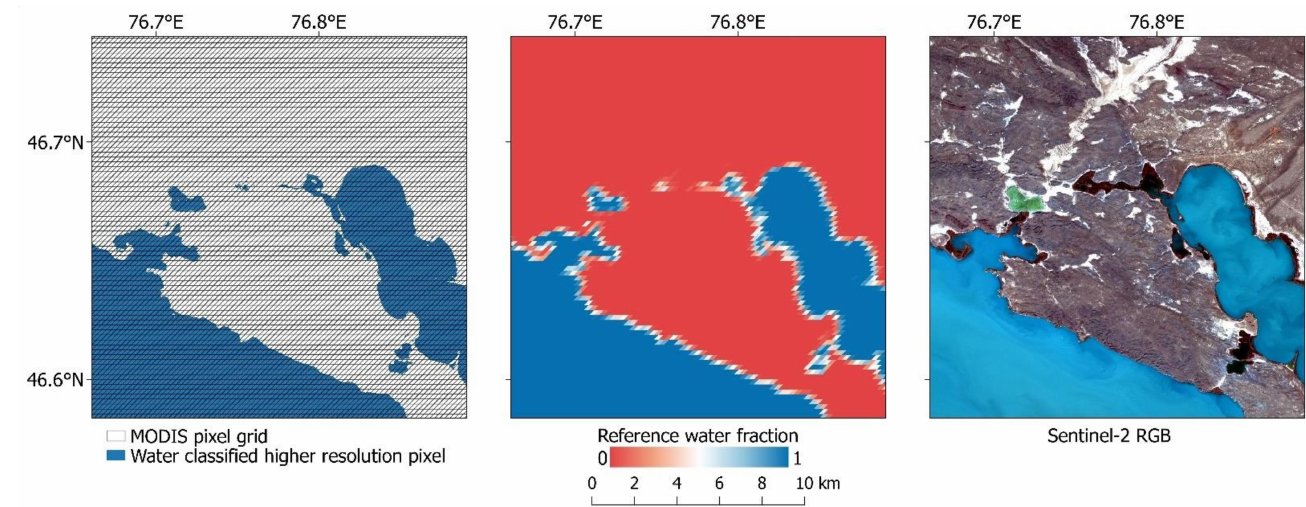
Figure 3. Allocation of classified Sentinel-2 reference pixels to larger MODIS pixels to gain reference water fraction estimates. Data: Sentinel-2 tile R048 T43TFM, 2019-10-23.